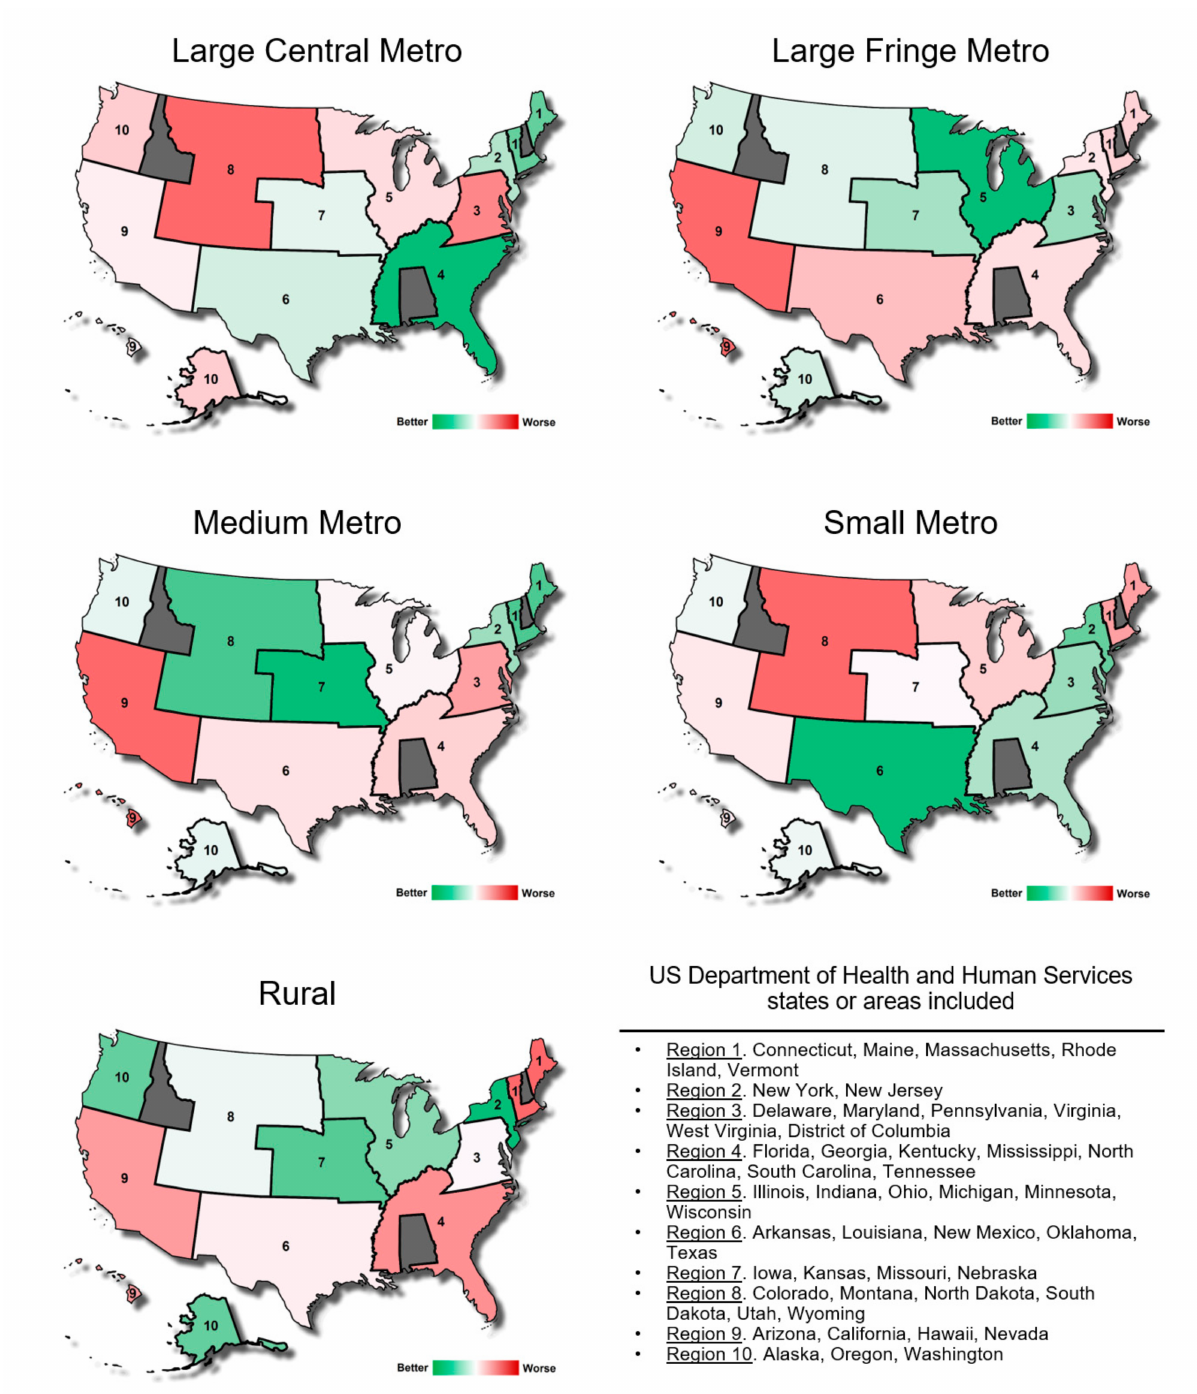
Figure 2. Opioid-related inpatient stays and emergency department visit incidence estimation compared between 10 regions of the United States as defined the Department of Health and Human Services across the five community population sizes. These estimations consider demographic